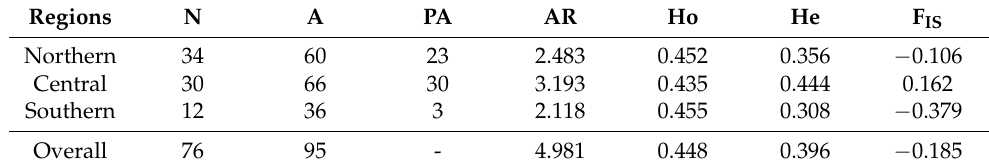
Table 2. Genetic diversity indexes calculated for Ilex guayusa in the three Ecuadorian Amazon regions. Regions N A PA AR Ho He F IS Northern 34 Central 30